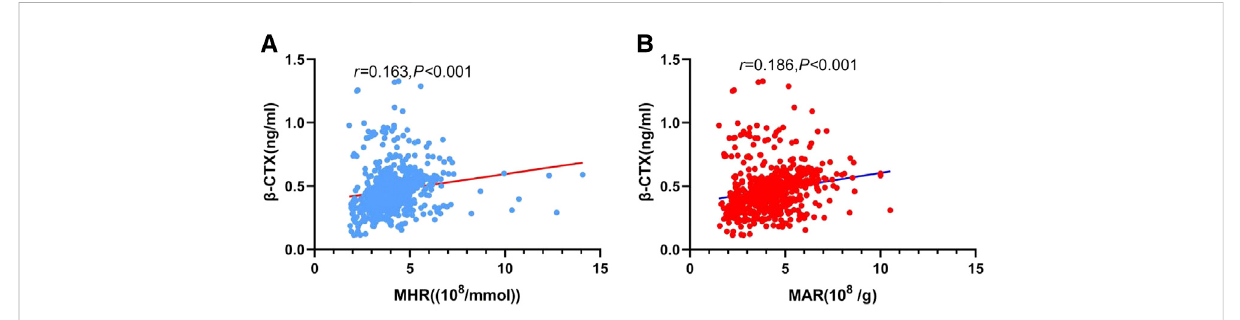
FIGURE 2 Correlation analysis showing positive correlation between β -CTX and MHR (A) , MAR (B) .